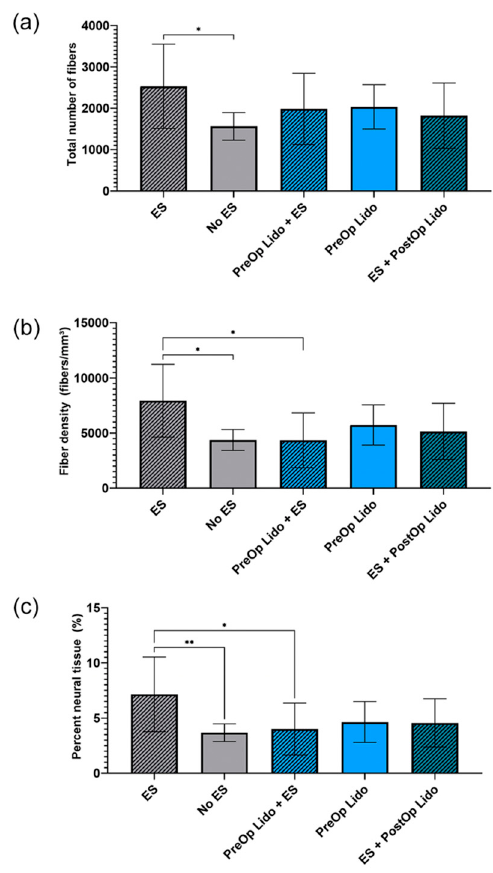
Figure 3. Keane et al. investigated the interaction between perioperative lidocaine (3 mL of 2%) and 10 min of postoperative ES (20 Hz). Rats were randomized to receive ( a ) ES alone, ( b ) ES + pre-operative (PreOp) lidocaine, or ( c ) ES + post-operative (PostOp) lidocaine. Quantitative evaluation of histomorphometric parameters 21 days after tibial nerve transection and repair. Data was expressed as mean ± SD ( n = 12/group). ** p < 0.01, * p < 0.05. Lido = lidocaine; SD = standard deviation; ES = electrical stimulation. Used with permission from SAGE publishing from Keane, G.C.; Marsh, E.B.; Hunter, D.A.; Schellhardt, L.; Walker, E.R.; Wood, M.D. Lidocaine Nerve Block Diminishes the Effects of Therapeutic Electrical Stimulation to Enhance Nerve Regeneration in Rats. Hand (NY)